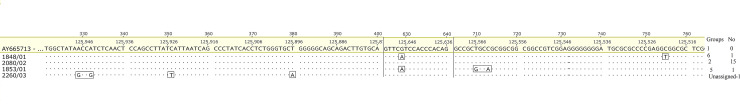
Sequences of EHV-1 ORF68 are aligned with reference sequence (GenBank AY665713.1).The representatives of variation in sequences in archived isolates are shown and the position of nucleotide relative to Ab4 (GenBank AY665713.1) are numbered. The sequence identity is denoted by dots and non-synonymous changes are highlighted.